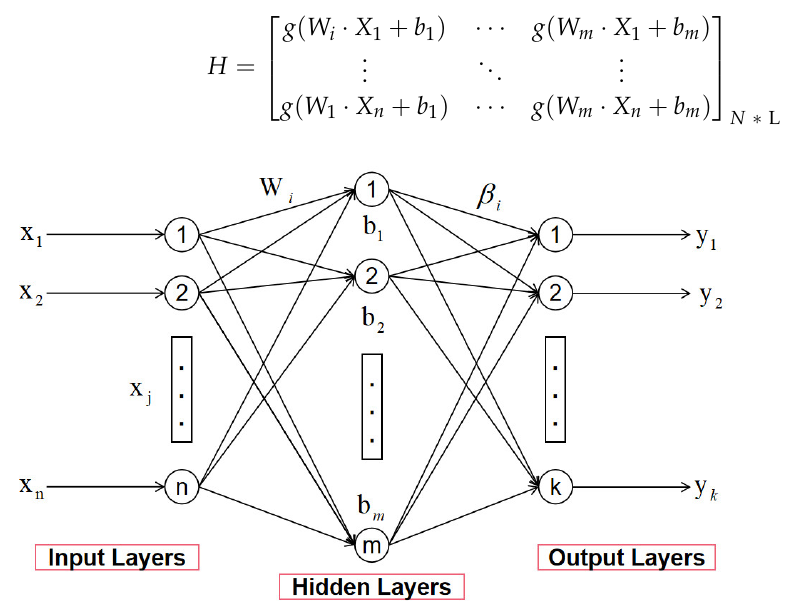
Figure 1. Network structure diagram of extreme learning machine.